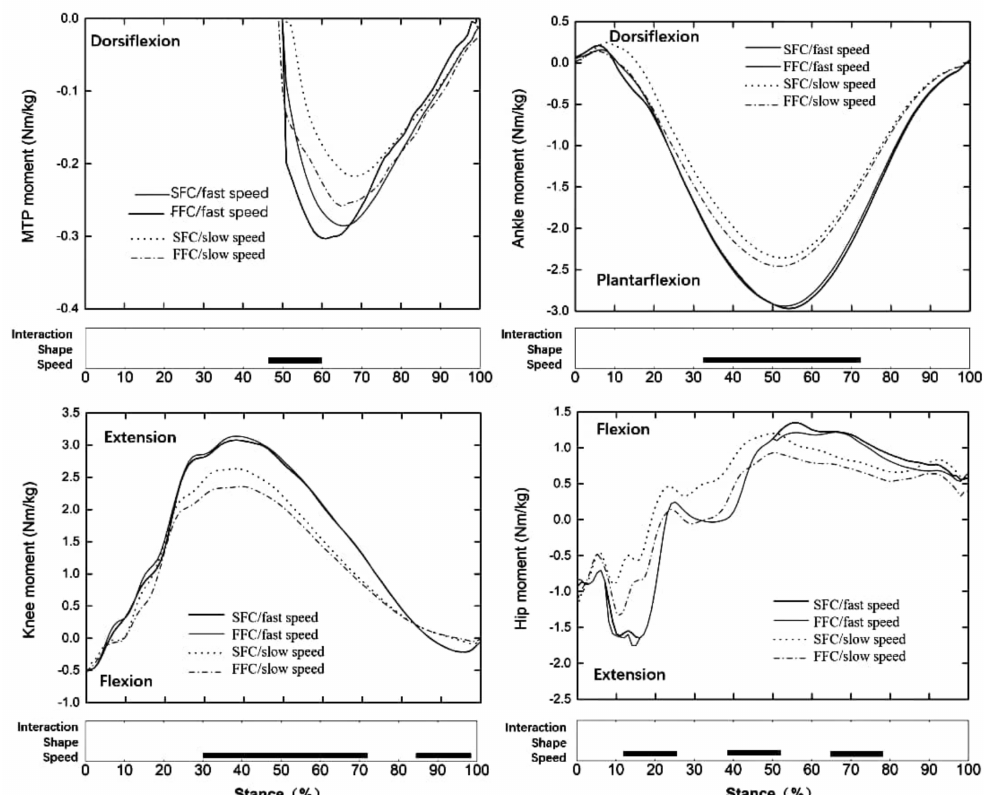
Figure 6. Lower limb joint moment time and weight − normalized. Note: The significant main effects of the interaction, the location, and the speed are highlighted (black horizontal bars at the bottom of the figure) during the stance phase of running.